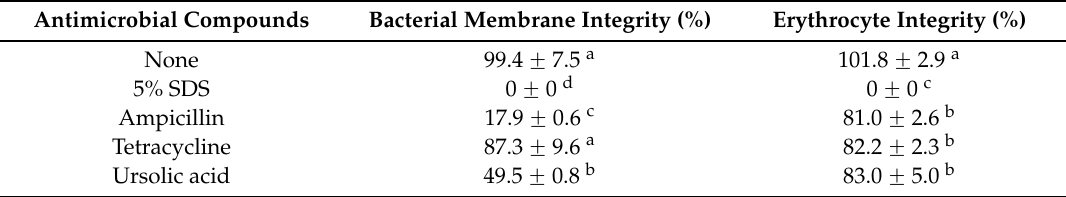
Different letters represent values that were significantly different at α = 0.05